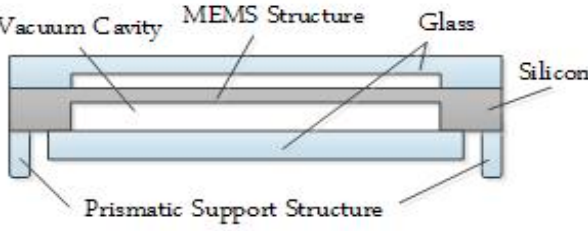
Figure 5. Structural design of the MEMS chip.